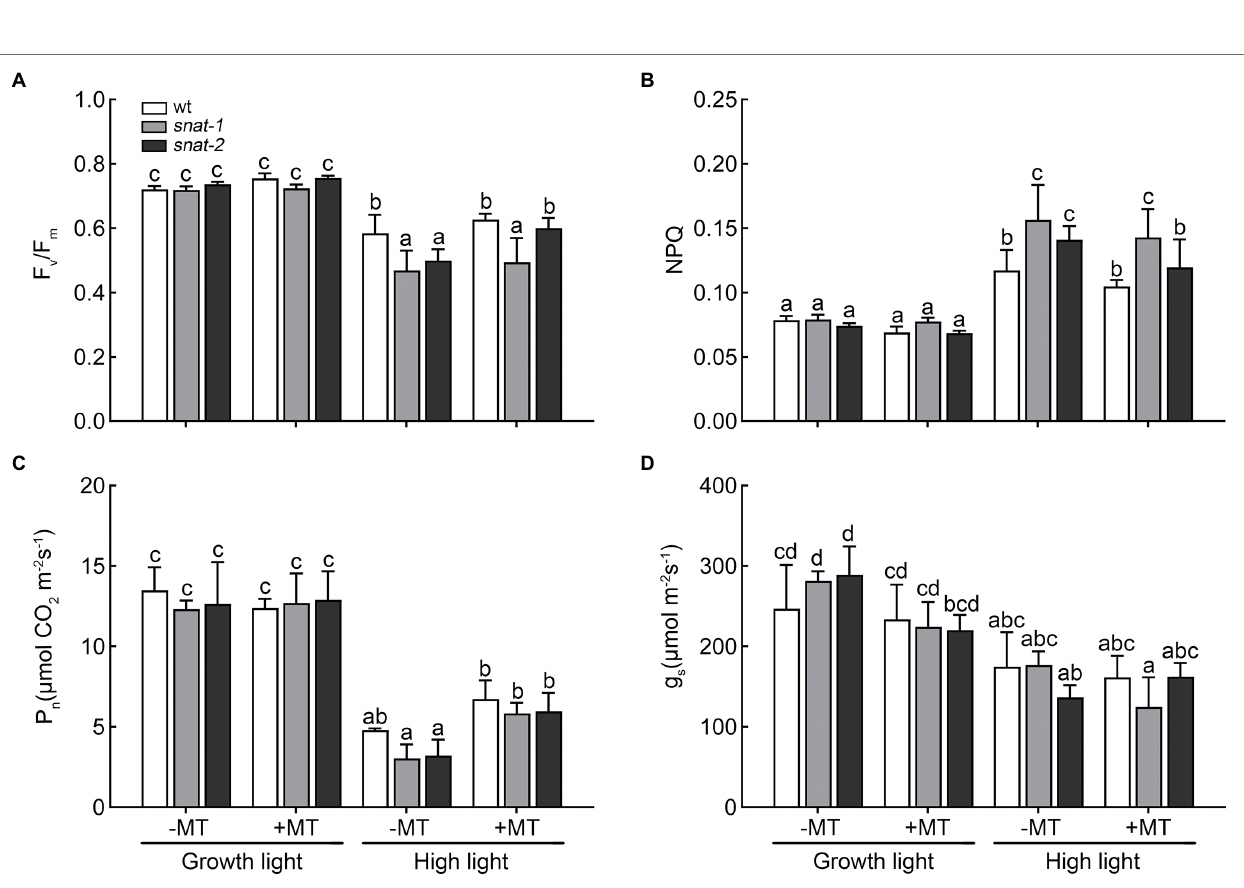
FIGURE 3 | Effects of exogenous melatonin on photosynthesis. (A) Maximum PSII quantum yield (F v /F m ). (B) Non-photochemical quenching (NPQ). (C) Net photosynthetic rate ( P n ). (D) Stomatal conductance ( g s ). Others are the same as in Figure 1